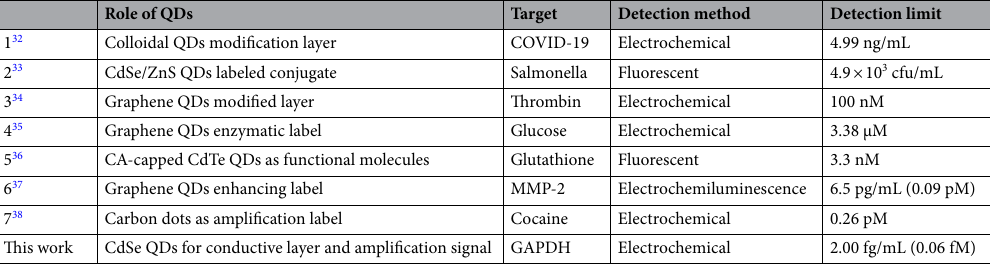
Table 1. Comparison with other QDs